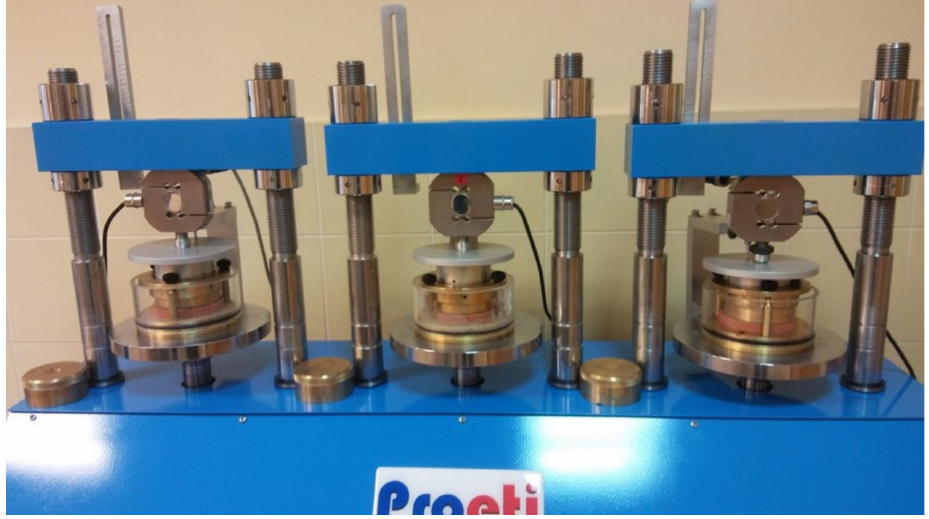
Figure 4. Apparatus used in oedometric